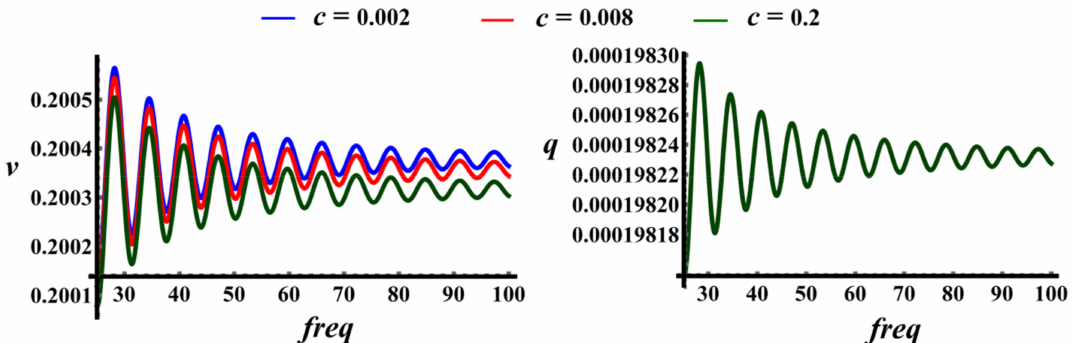
Figure 34. The output voltage and the current versus excitation frequency with the variation of the damping